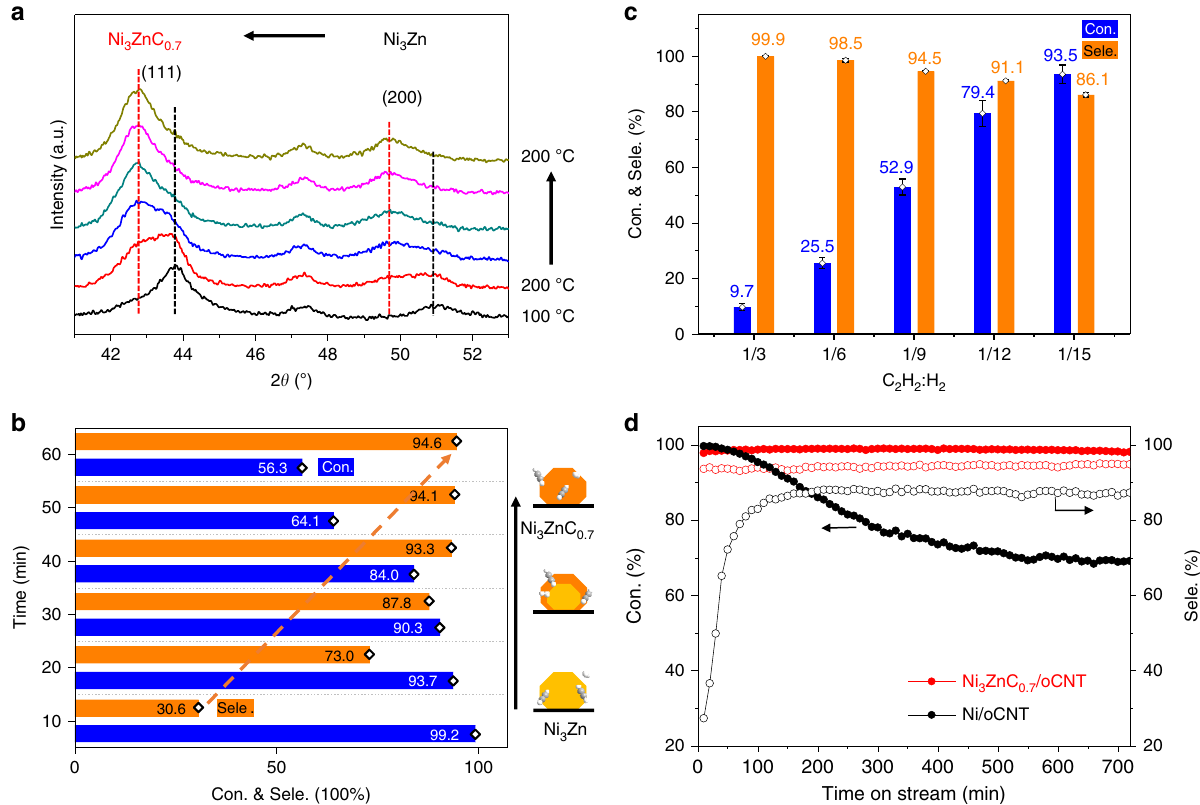
Fig. 3 Catalytic performance in acetylene selective hydrogenation reaction. a In situ XRD patterns of the structural evolution from Ni 3 Zn to Ni 3 ZnC 0.7 (black curve: 100 °C, other curves: 200 °C with prolonged times) under a 1.0 vol% C 2 H 2 /He atmosphere. b The reactivity corresponds to the structural evolution of Ni 3 Zn/oCNT catalyst under reaction conditions. c Conversion and selectivity of Ni 3 ZnC 0.7 /oCNT catalyst (5.0 mg) under various acetylene to hydrogen ratios. Error bars represent standard deviation of experimental data acquired from three times. d Stability test (4.5 vol% H 2 , 20.0 vol% C 2 H 4 , 0.5 vol% C 2 H 2 , helium as balance) of Ni/oCNT (15.0 mg) and Ni 3 ZnC 0.7 /oCNT (10.0 mg) catalysts. The solid and hollow symbols represent the acetylene conversion and the selectivity to